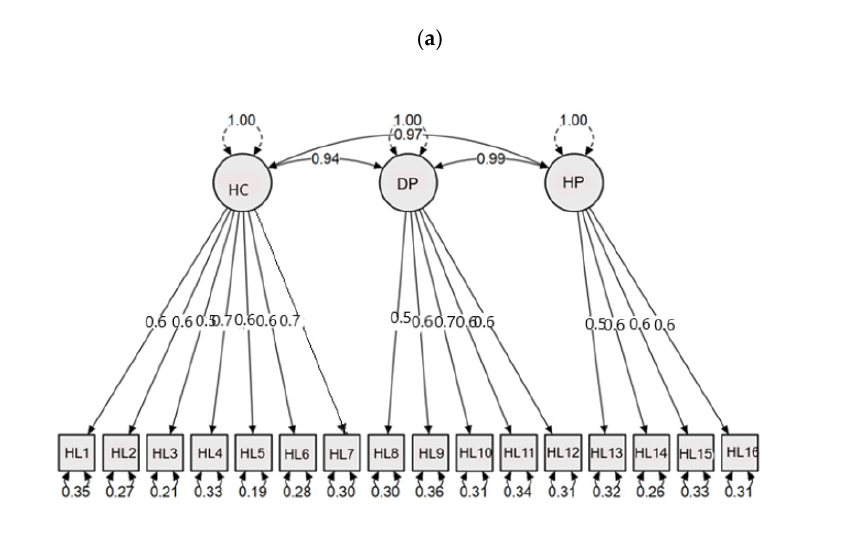
Table 1. Fit indices of measurement model for the Indian versions of the HLS-EU-Q16. Hindi Version Kannada Version Compliance Criteria Domain Sub-Domains Domain Sub-Domain